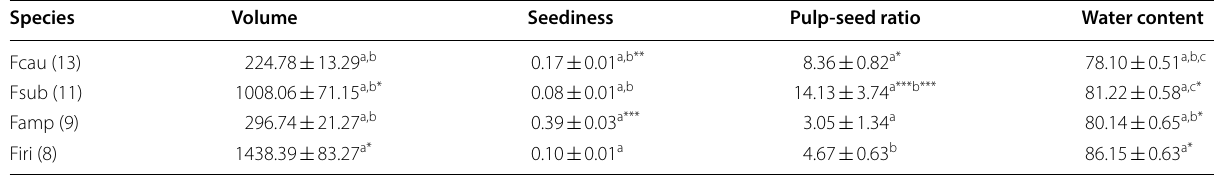
Table 3 Mean ( SE) fig volume (mm 3 ), seediness (seeds/mm 3 fig volume), pulp-seed ratios, and water contents (%) ± of four species of figs ( n tree number) assessed in HTBG and the comparison examined by MANCOVA =